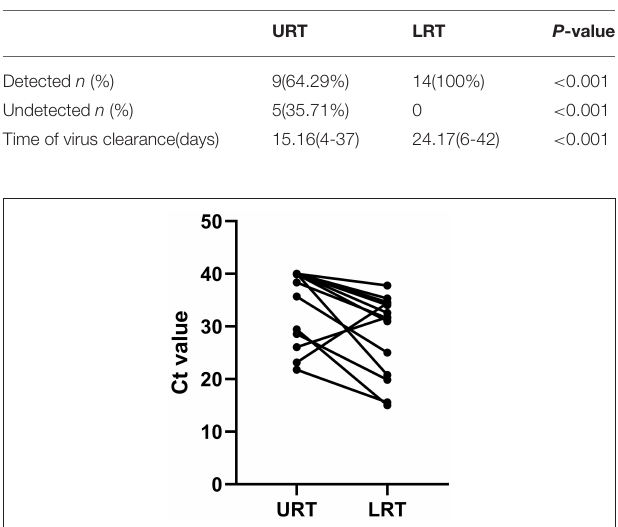
TABLE 3 | Comparison of multiplex Q-PCR results between URT and LRT samples.